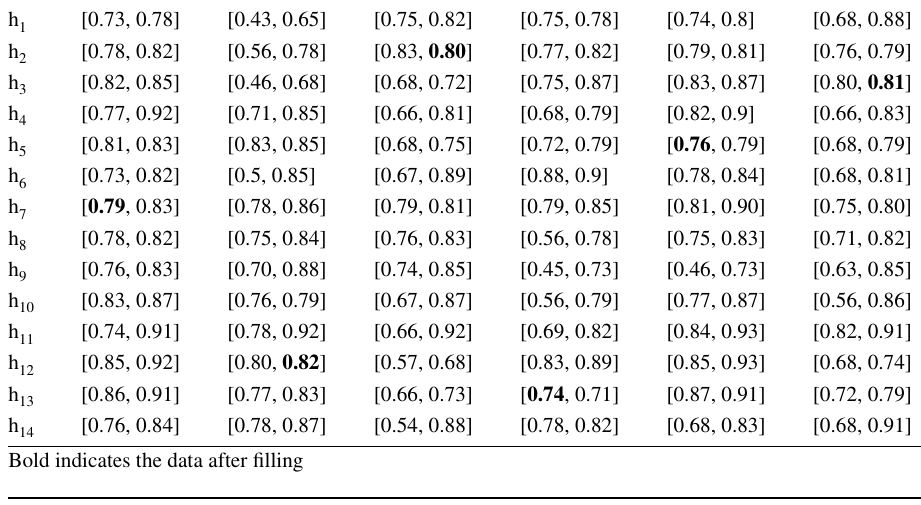
Table 11 Filling results by our method for Table 9